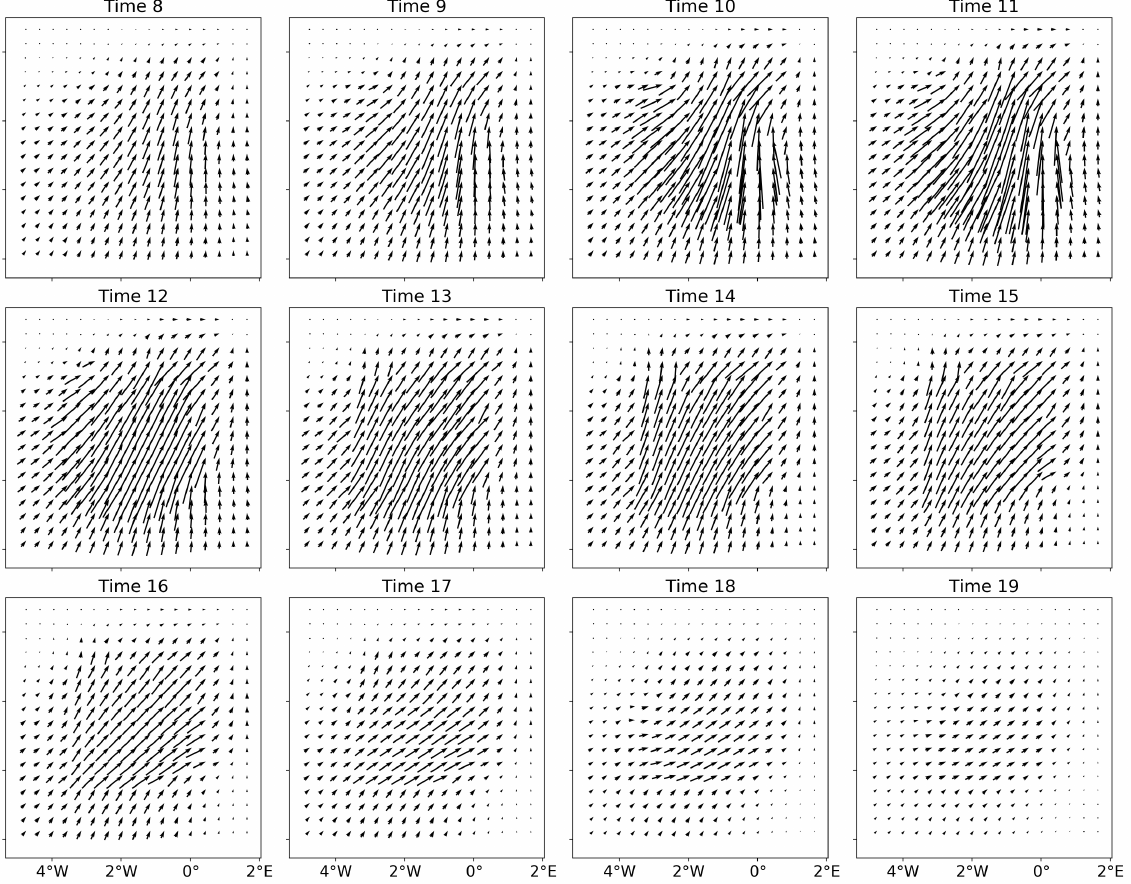
Figure 6. Mappings T s for selected time